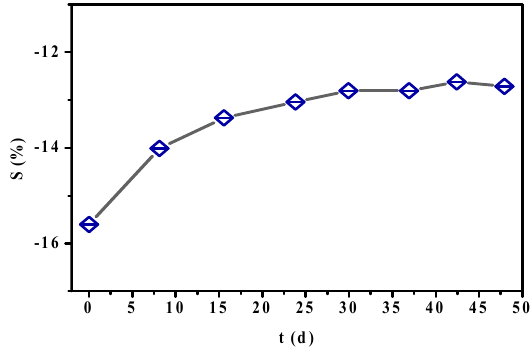
Figure 8. Stability curves of PANI-SSA sensor to H 2 S.